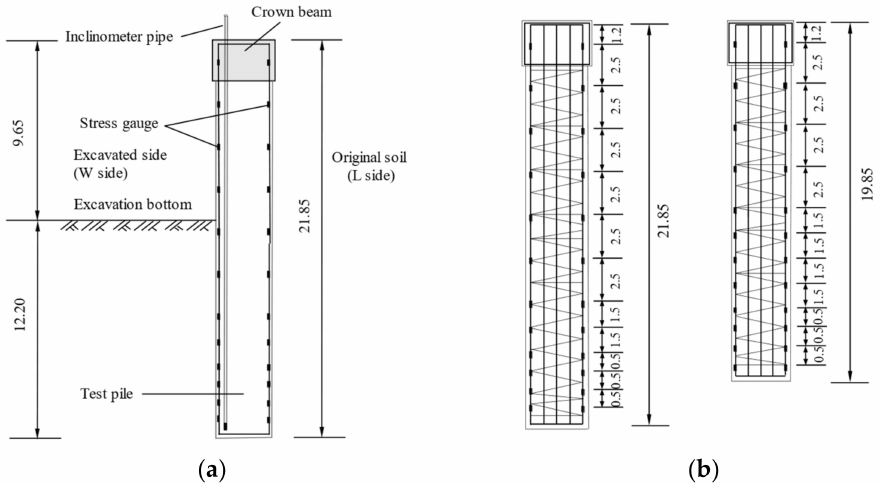
Figure 5. Schematic diagram of retaining pile stress gauge and inclined pipe layout (unit: m):